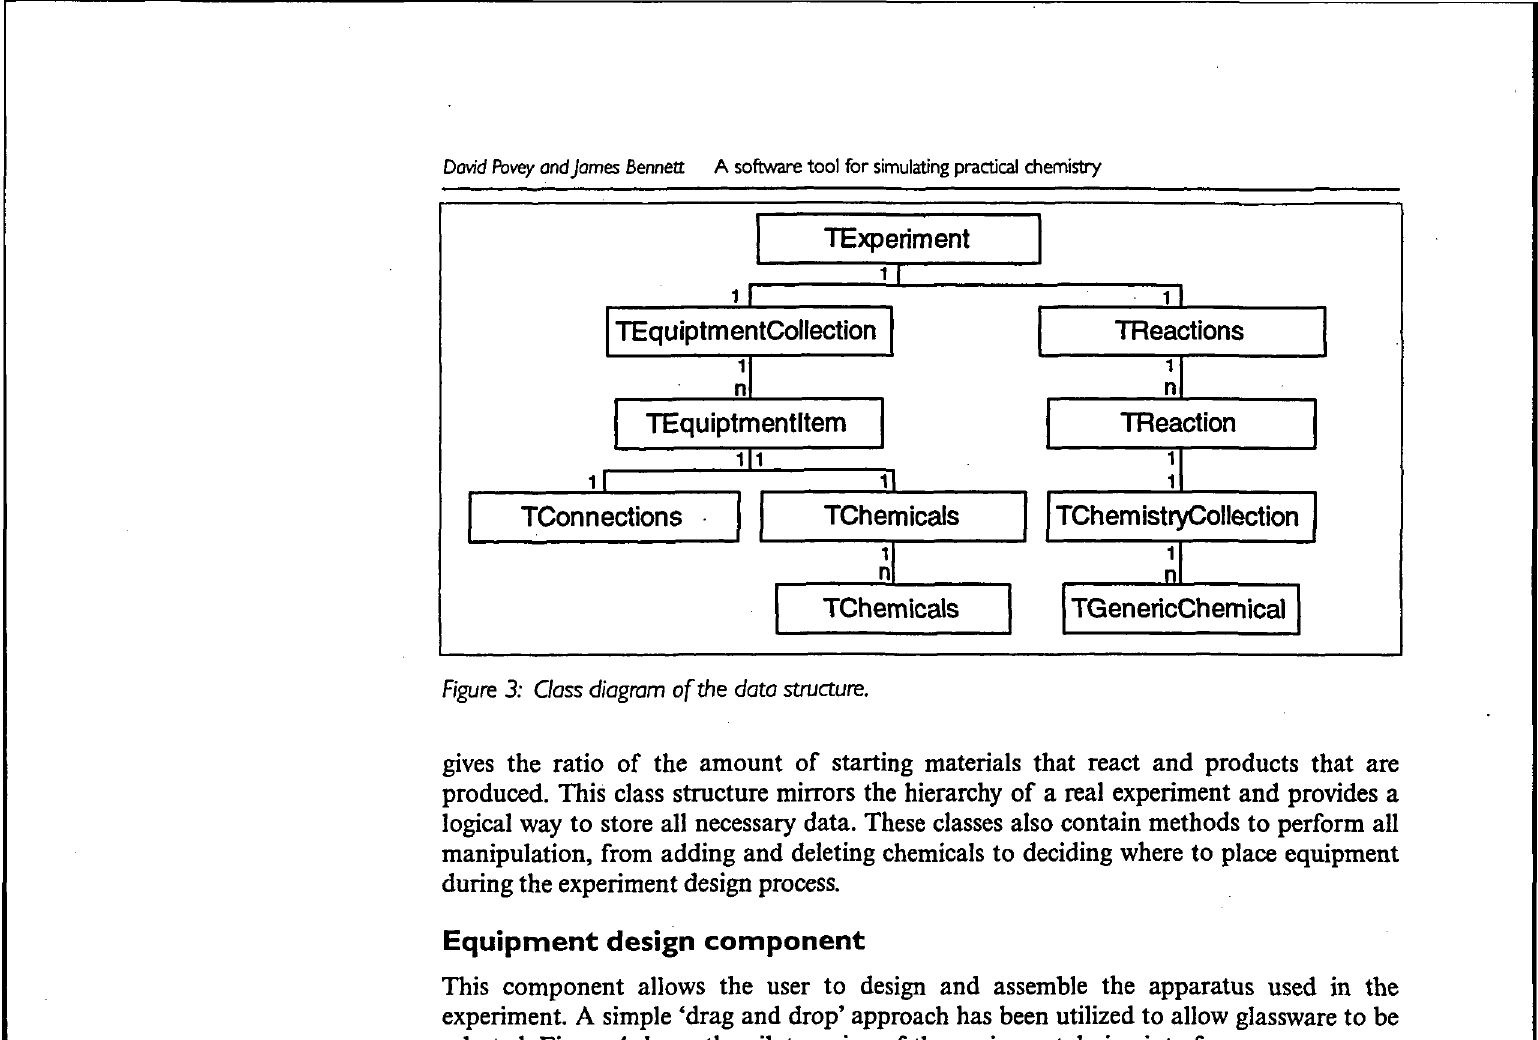
Figure 4: The equipment design